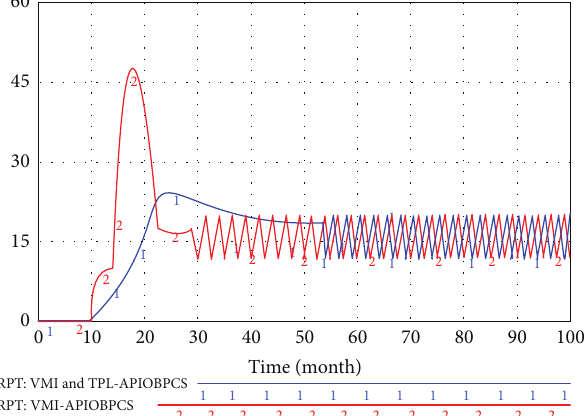
Figure 17: The comparison of replenishment batch fluctuation.